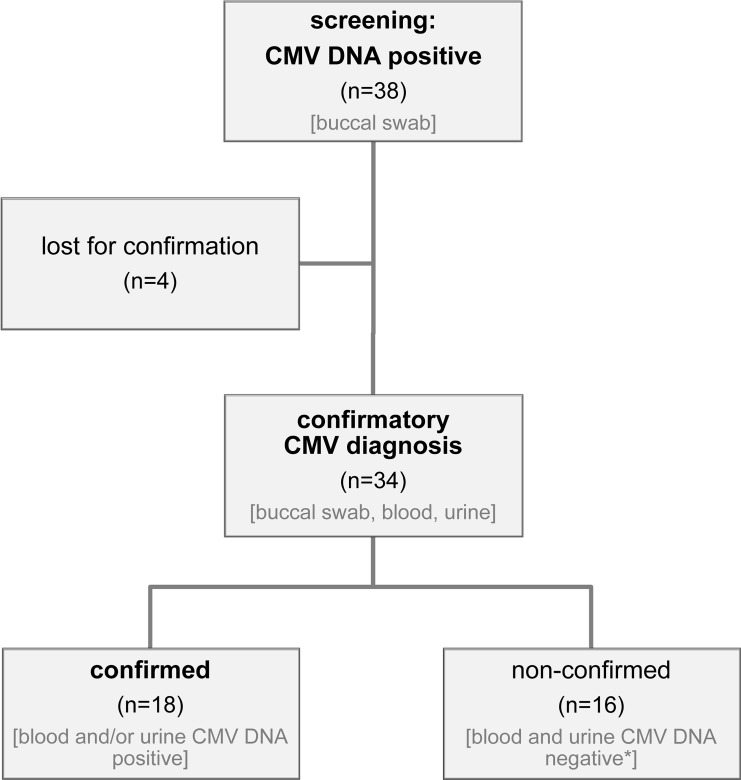
Flow chart of confirmatory CMV diagnostics.34 out of 38 patients whose saliva samples (buccal swabs) were tested positive in CMV DNA screening could be included in confirmatory diagnostics. Confirmation of cCMV infection was defined as CMV DNA detection in blood and/or urine. *including 3 swab samples that were again tested positive for CMV DNA.